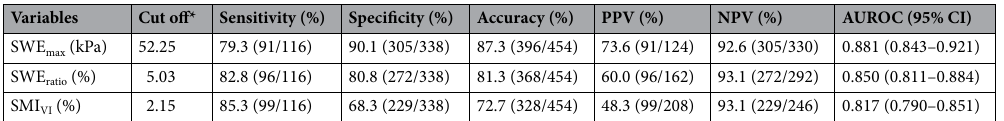
Table 1. Diagnostic performance of quantitative parameters of SWE and SMI. Data are percentages with the number of malignancies or the number of lesions in parentheses. PPV: Positive predictive value, NPV: Negative predictive value, AUROC: Area under the receiver operating characteristics curve, CI: Confidence interval. *The optimal cut off values for SWEmax, SWEratio and SMI VI were determined based on the Youden’s index.